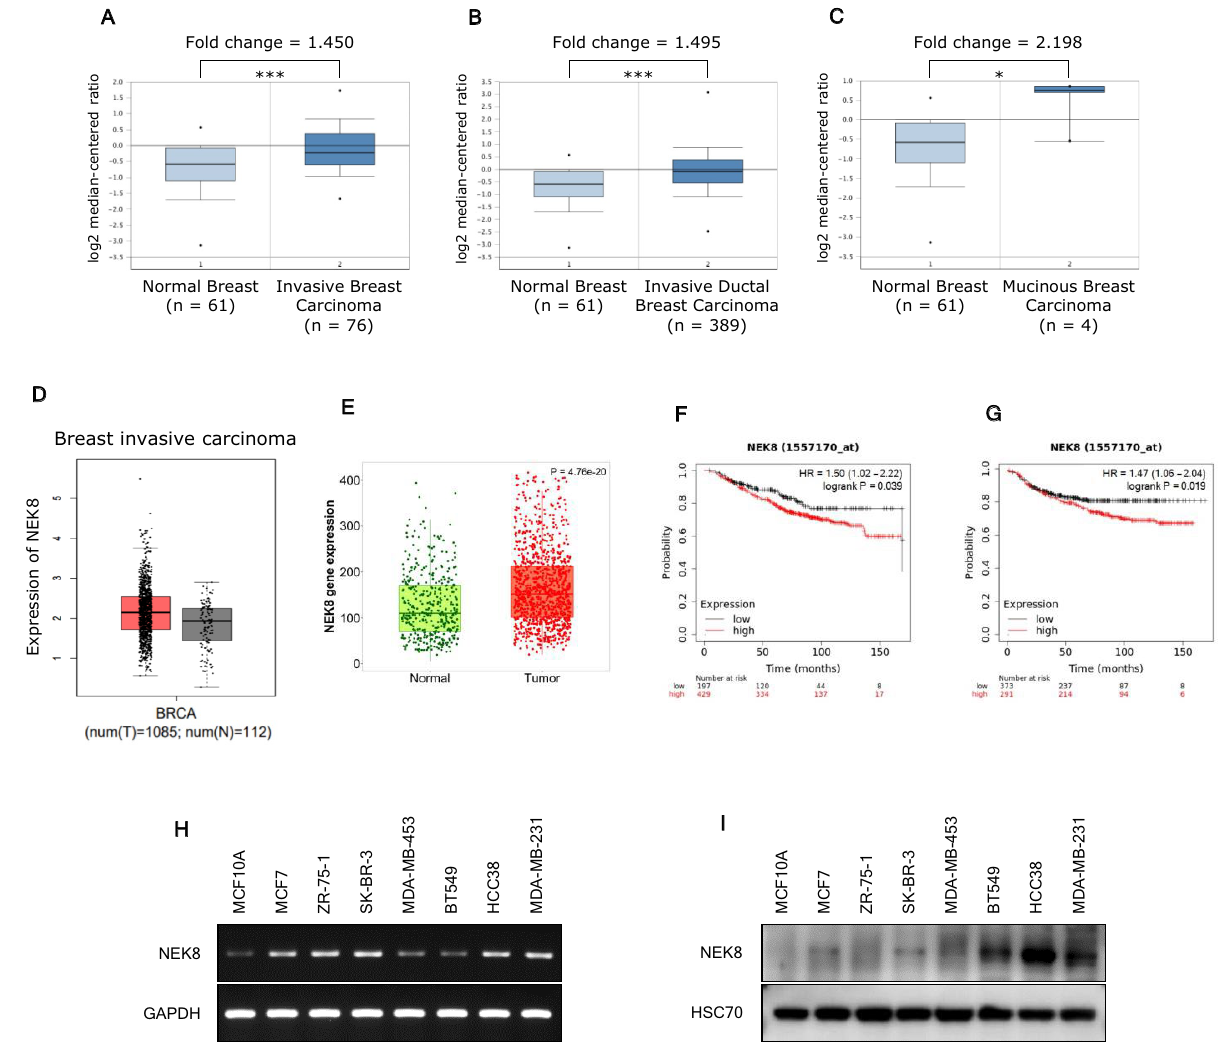
Figure 1. Increased never in mitosis gene A-related kinase-8 ( NEK8 ) expression is associated with poor survival in patients with breast cancer. ( A ) NEK8 mRNA expression in normal breast tissues and invasive breast carcinomas from the Oncomine database. ( B ) NEK8 mRNA expression in normal breast tissues and invasive ductal breast carcinoma from the Oncomine database. ( C ) NEK8 mRNA expression in normal breast tissues and mucinous breast carcinoma from the Oncomine database. Error bars, standard deviation; *** P < 0.001, ** P < 0.01, * P < 0.05. ( D ) NEK8 mRNA expression determined using RNA-sequencing in normal and tumour tissues from TNMplot.com. ( E ) NEK8 expression in breast invasive carcinoma and normal tissues from the Gene Expression Profiling Interactive Analysis (GEPIA) database. Kaplan–Meier curves indicating ( F ) overall survival (OS) and ( G ) distant metastasis-free survival (DMFS) of patients with breast cancer were produced using the Kaplan–Meier plotter. ( H ) NEK8 mRNA level in breast cancer and normal cell lines. GAPDH was used as a loading control. ( I ) NEK8 protein expression in breast cancer and normal cell lines. HSC70 was used as a loading control. The blots were cut prior to incubation with